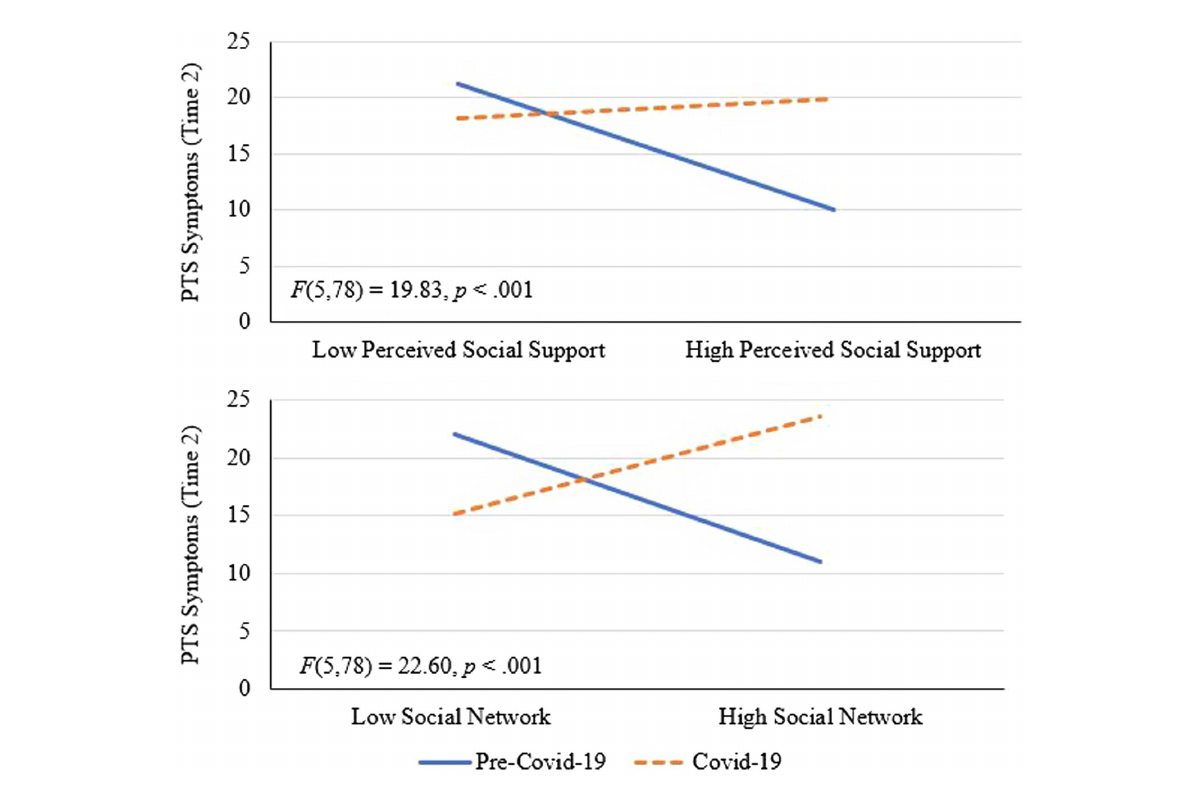
FIGURE 2 Interactions between perceive social support and cohort and social network and cohort in the prediction of post-traumatic stress symptoms at Time 2. PTS symptoms denotes post-traumatic stress